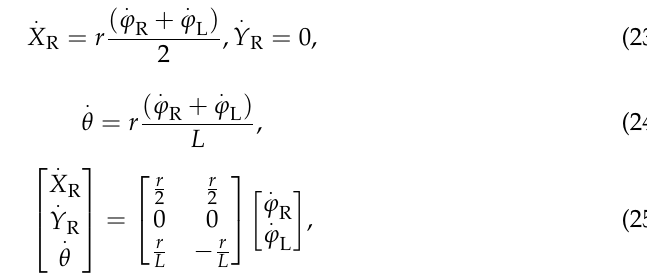
where v is average speed of two rounds, ω is the angular velocity, v R is the speed of right wheel, v L is the speed of left wheel, L is the distance between left wheel and right wheel, . . r is the radius of the wheel, ϕ ϕ and are the angles of rotation of left wheel and right R L wheel. The velocities in the robot coordinate system can be expressed as in (23) and (24), and it can be also expressed in matrix form in